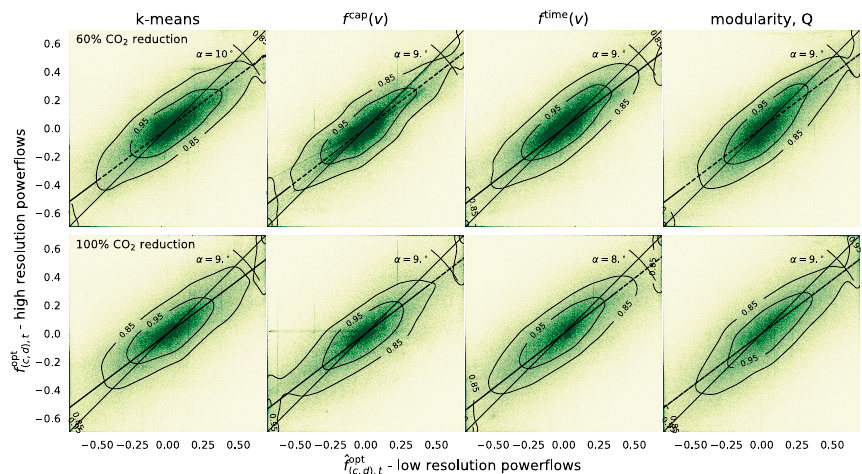
Fig. 9 Normalised mapping of optimal power flows according to equation (11) with the estimated flows of the low resolution model ˆ f ( c , d ) , t on the x-axis and the aggregated flows on the y-axis. The first row shows results on the 60% , the second row on the 100% reduction target. Instead of presenting the raw data, we plot a two dimensional histogram and outline the 95% and 85% percentiles of the corresponding probability density function (PDF) using contour plots. The black line depicts the origin (perfect correlation), the dashed one a line with the slope of the bivariate correlation coefficient ρ . α is the angle between the two lines